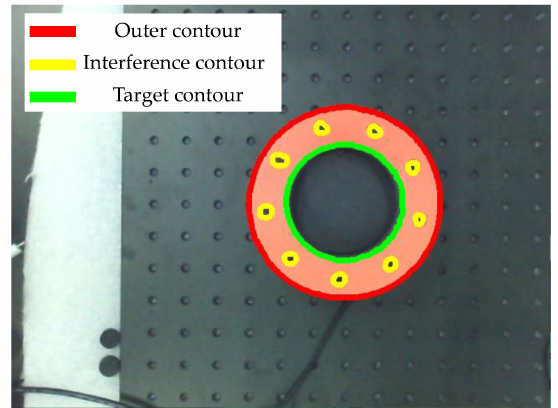
Figure 5. Different contours of the 3D printing flange